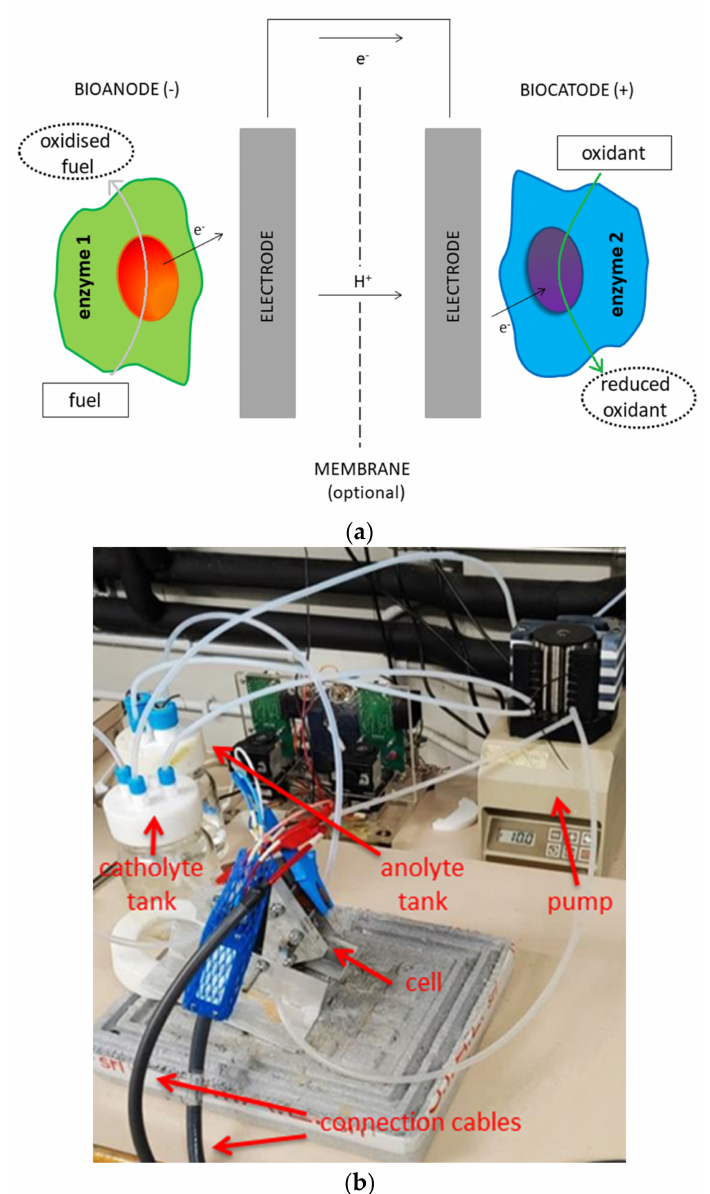
Figure 1. ( a ) Schematic view of a typical EBC (reproduced from [3]) and ( b ) experimental test rig for the developed